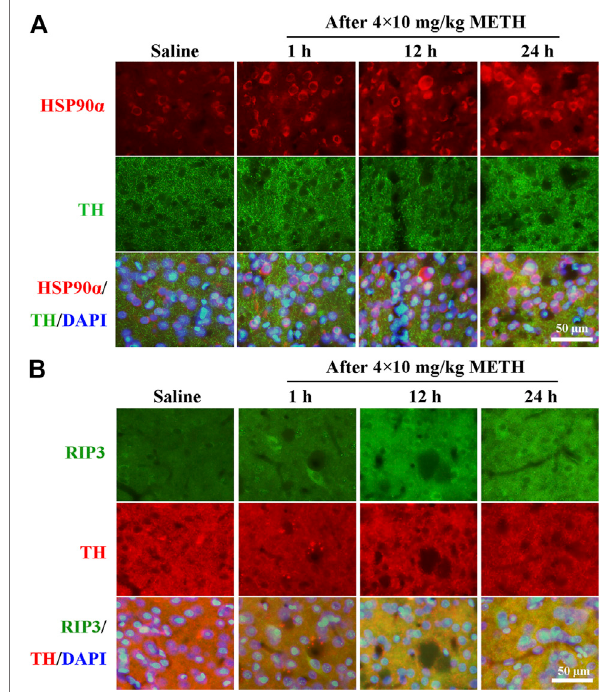
FIGURE 8 | Detection of HSP90 α and RIP3-positive cells in the rats ’ striatum following METH administration by IF. (A) IF staining of HSP90 α (red) andtyrosinehydroxylase(TH)(green)1,12,and24 hafterthelastinjectionofa binge dose of METH (4 × 10 mg/kg, every 2 h, i.p.) or saline. (B) IF stainingofRIP3 (green) and TH(red) 1,12, and 24 h after the last injection ofa binge dose of METH. Scale bar (cid:2) 50 μ m in all panels.